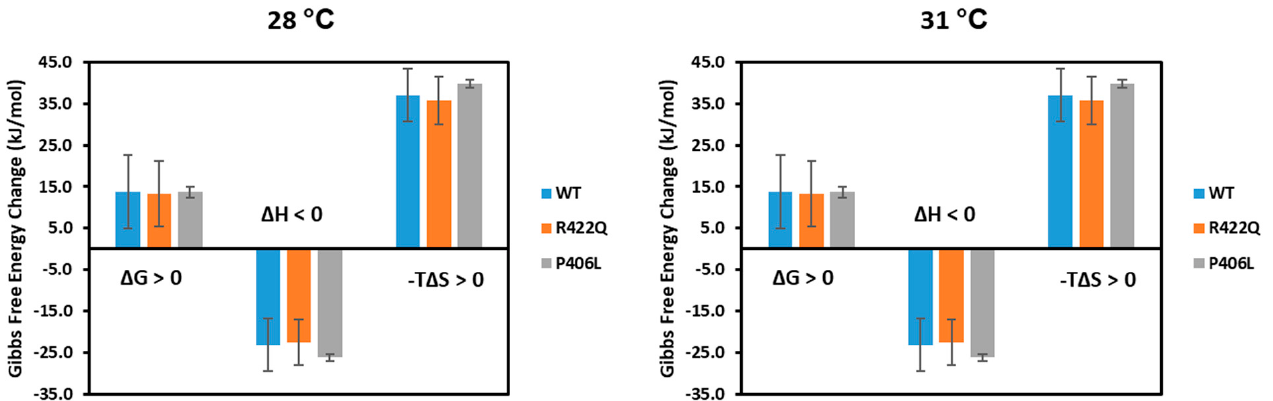
Figure 5. The apparent thermodynamic signatures of the diphenol oxidase reactions suggest reactions driven by enthalpy and entropy forces. WT, R422Q, and P406L are shown in blue, orange, and gray, respectively. All experiments were per- formed in duplicates and error bars represent standard deviations. The thermodynamic signatures for the docking simu- lations are shown in the Supplementary Materials Figure S3. Table 2 feature the apparent Δ H and Δ S. Table 2. Enthalpy and entropy of WT, R422Q, and P406L obtained from Van’t Hoff analysis of the diphenol oxidase reac- tions and computational simulations. Δ H Obs (kJ/mol)